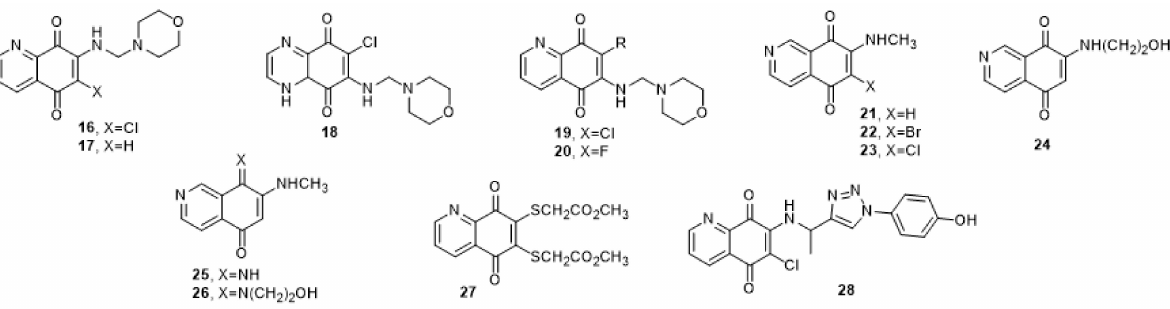
Figure 4. Quinone structural analogs of vitamin K 3 substituted with heteroatoms in the benzene